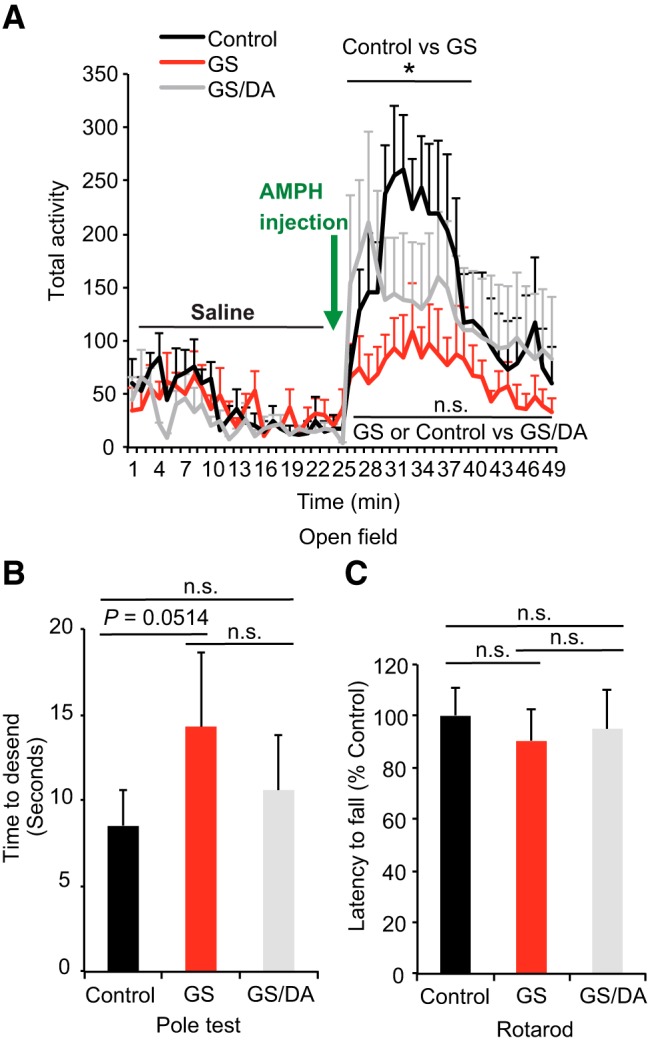
Behavioral deficits of conditional LRRK2-G2019S transgenic mice. A, Open field analysis under normal conditions and following amphetamine challenge. Mice were placed in the center of the open field arena and allowed to explore the area for 25 min, following by d-amphetamine injection (7 mg/kg, s.c.) and another 25 min exploration. The total activities of mice were recorded every minute (control, n = 7; GS, n = 9; GS/DA, n = 8). B, Pole test to monitor the behavioral abnormalities of 22-month-old LRRK2 GS and GSDA transgenic and age-matched littermate controls (control, n = 8; GS, n = 8; GS/DA, n = 7). C, Assessment of latency to fall in an accelerated rotarod test (control, n = 8; GS, n = 9; GS/DA, n = 8). Data are the mean ± SEM. Statistical significance was determined by two-way ANOVA. *p < 0.05. n.s., Nonsignificant.